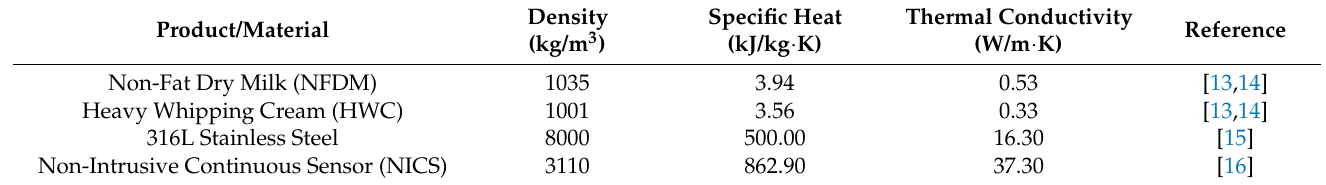
Table 1. Material properties used in the Computational Fluid Dynamics (CFD)